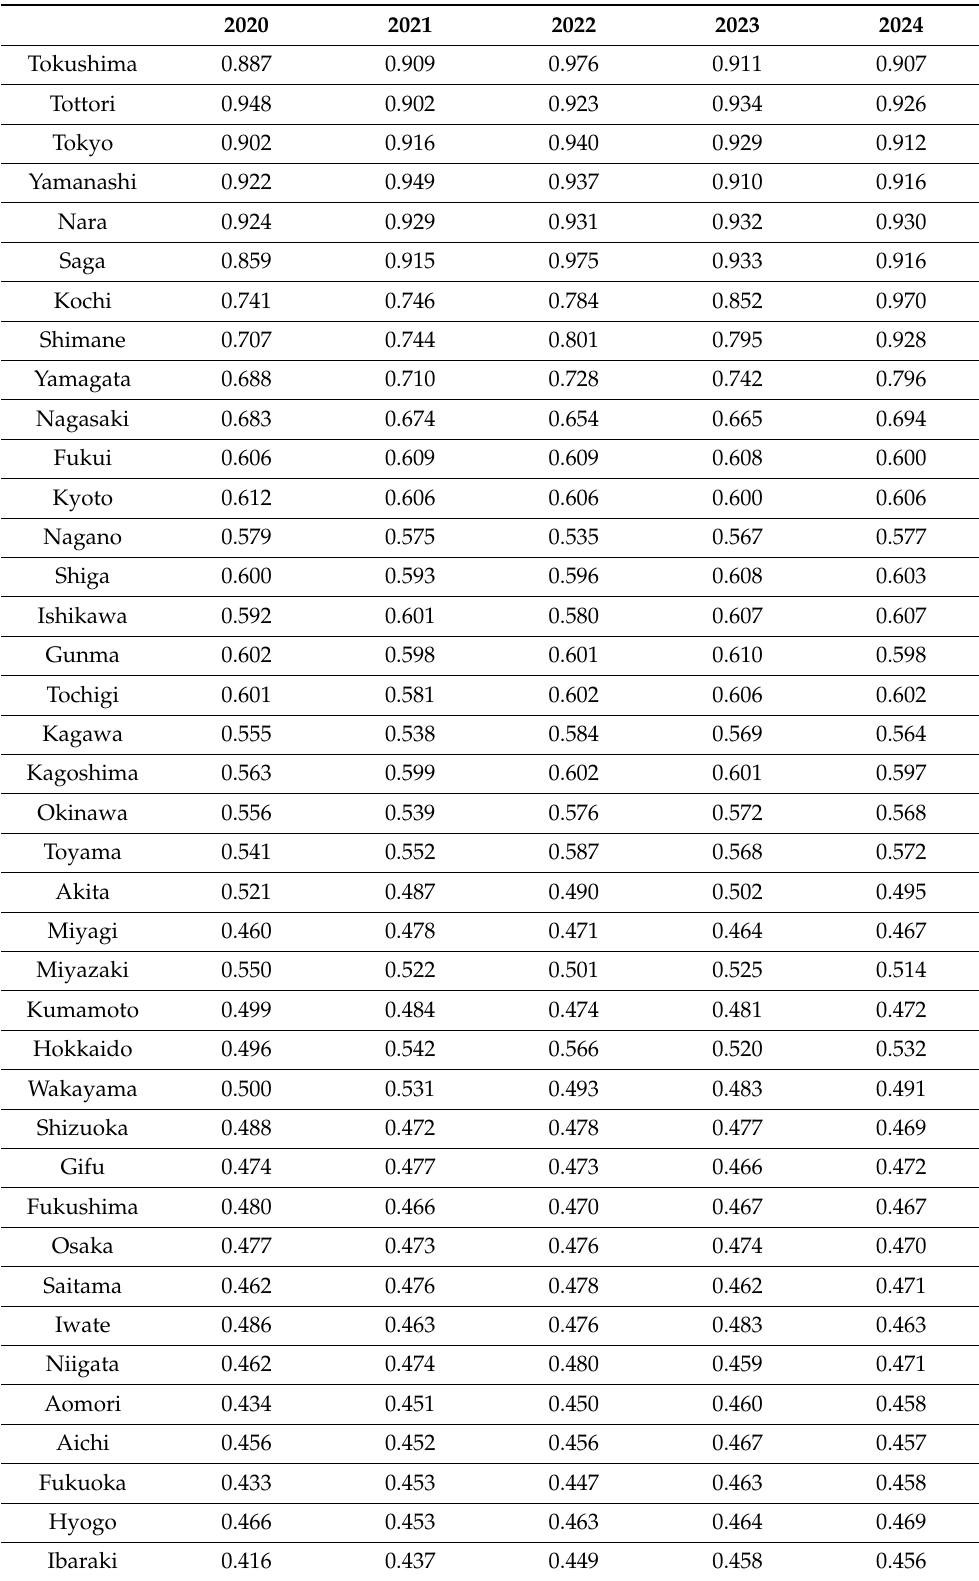
Table 10. Prediction results of the low-carbon economic efficiency value in Japan from 2020 to